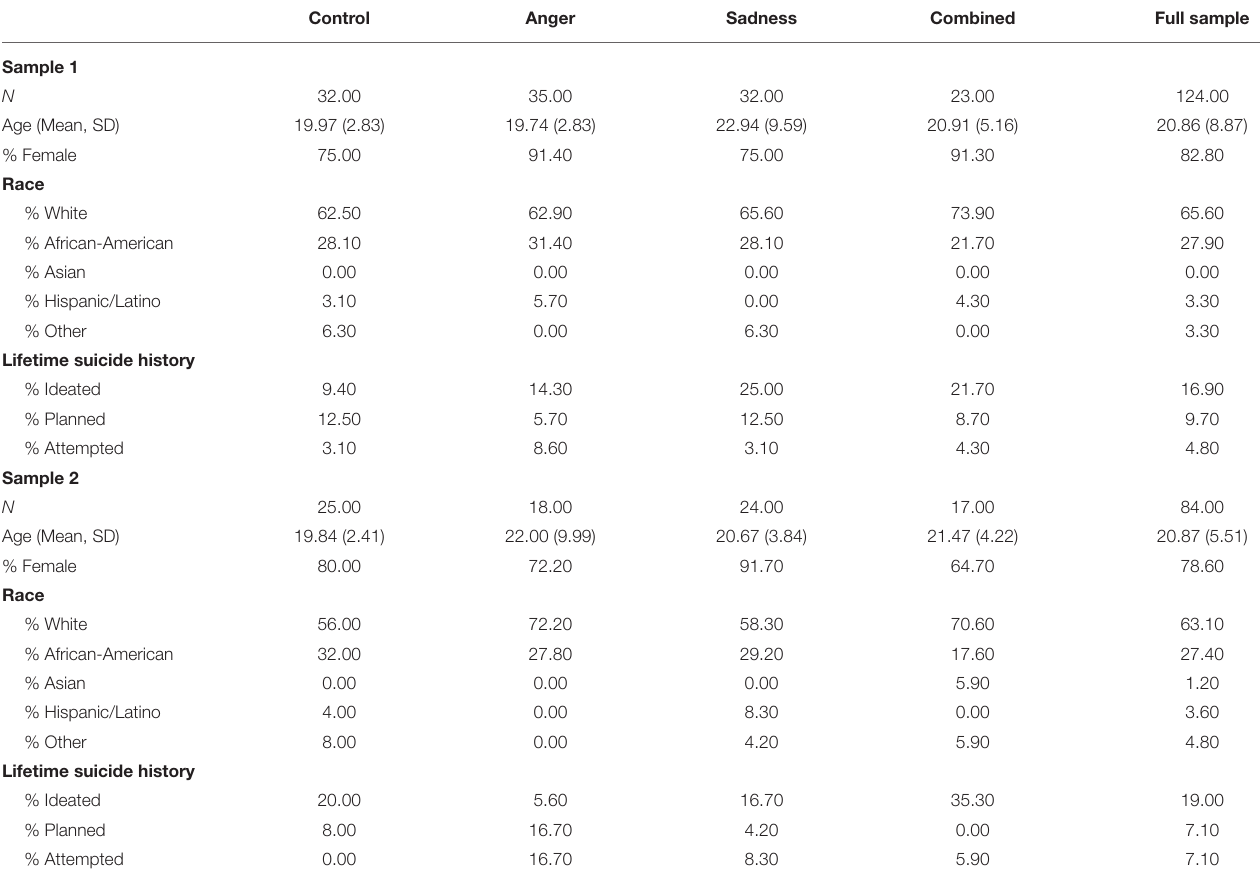
TABLE 1 | Participant demographic information. Control Anger Sadness Combined Full